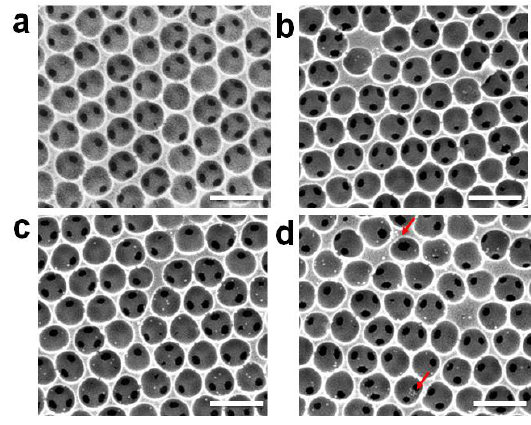
Figure 5. ( a – d ) SEM images showing the top surface of the IO nanostructure, where IO is treated with no virus ( a ), or 10 3 PFU ( b ), 10 4 PFU ( c ), or 10 5 PFU of the H1N1 subtype ( d ); Scale bars denote 500 nm.